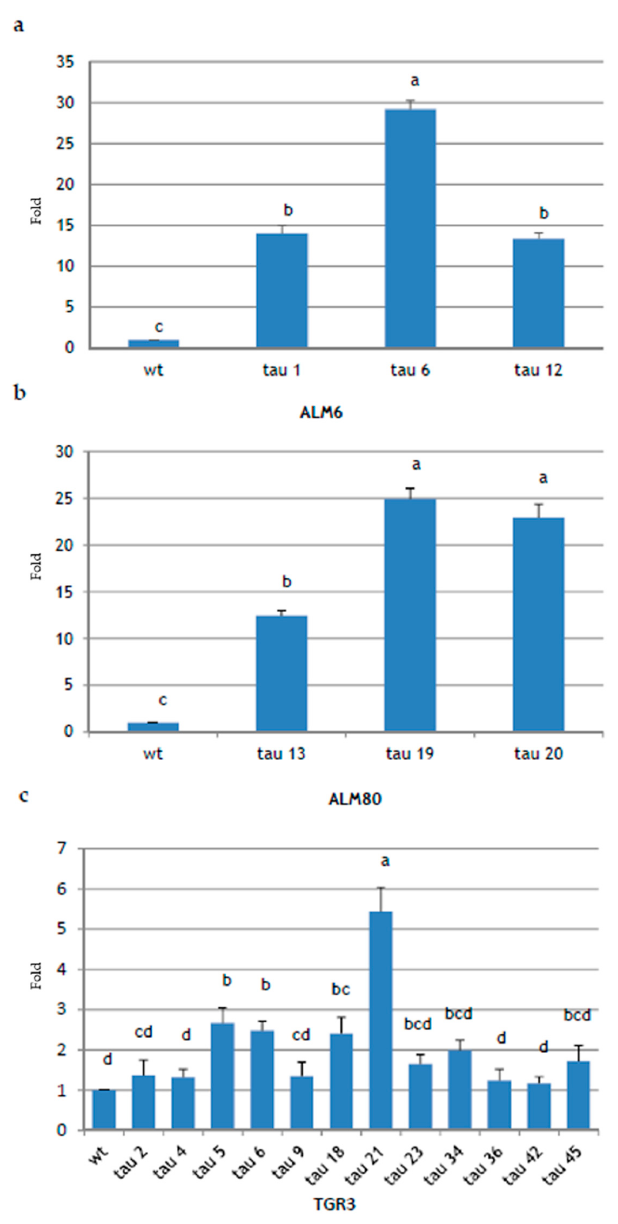
Figure 5. Expression analysis of CsTL1 gene in somatic embryos of cork oak determined by qPCR. Total RNA was extracted from 18 independent transgenic lines and the corresponding non-transgenic lines (wt) of three cork oak embryogenic genotypes: ALM6 ( a ), ALM80 ( b ) and TGR3 ( c ). Values are mean ± standard error from at least three independent experiments, and vertical lines indicate the standard errors of mean values. Data analyzed by ANOVA I ( p ≤ 0.05). Values in columns indicated with the same letter are not significantly different ( p = 0.05, Duncan’s